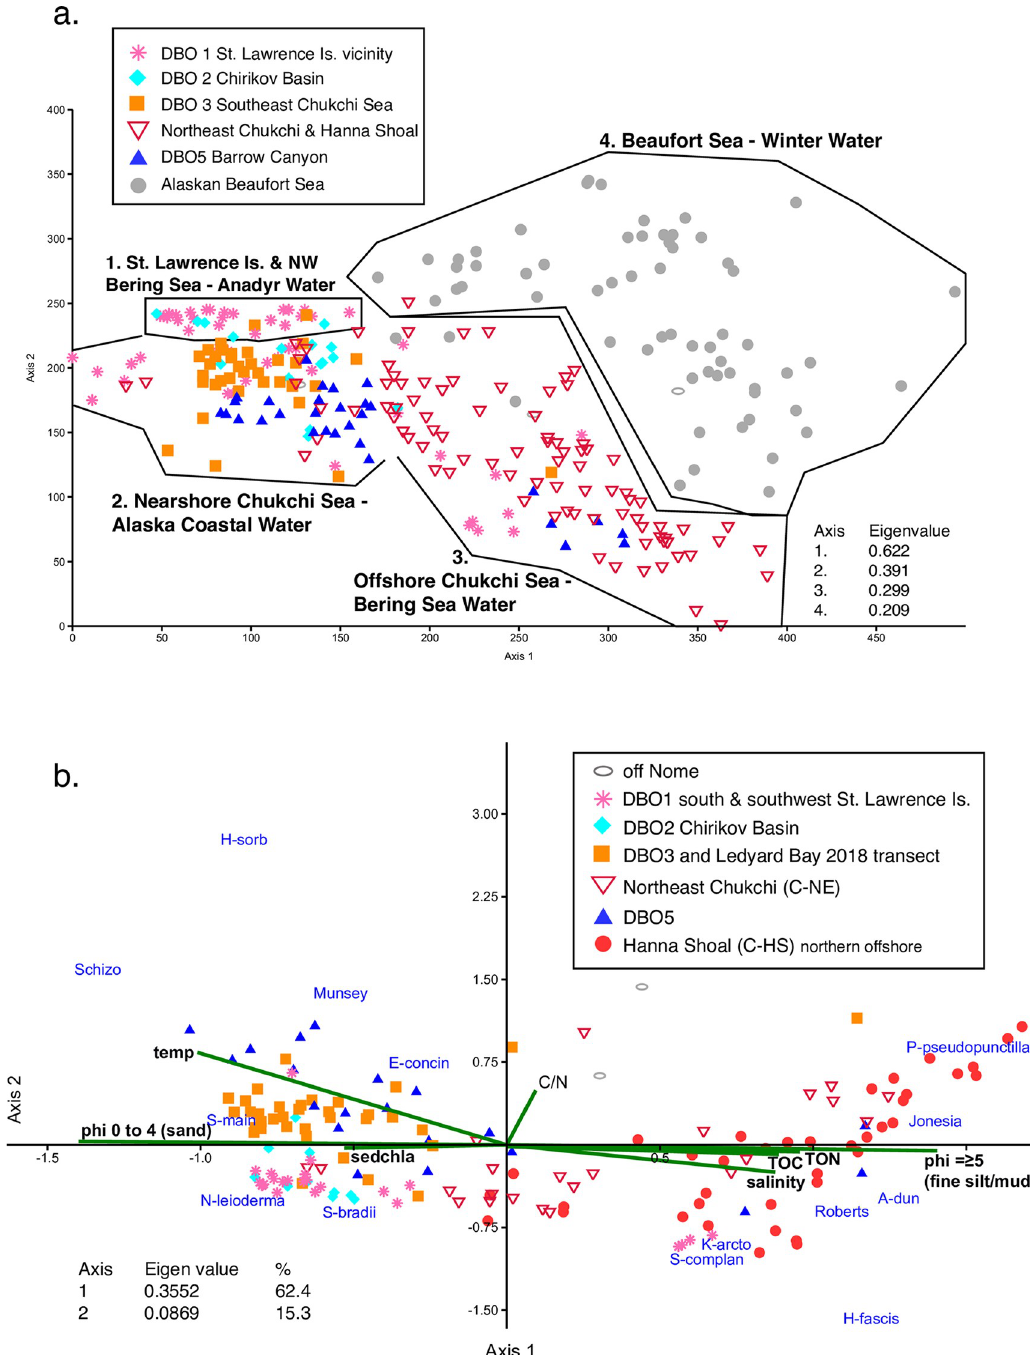
Fig 6. a . Detrended correspondence analysis (DCA). DCA using the northern Bering, Chukchi and Beaufort Seas biogeographic dataset (1970–2018), describes relationships between ostracode assemblage structure and geographic ecoregions in the region. Ostracode biofacies differed among ecoregions within the study area (described in Table 3) and grouped primarily on summer water mass characteristics (temperature and salinity). b . Canonical correspondence analysis (CCA). CCA of ostracode assemblages in the northern Bering-Chukchi Sea region, with sampling ecoregion sites (noted by symbol on legend), major taxa (names are labeled in blue), and eight environmental parameters (green lines and labels in black: temperature, salinity, sediment total organic carbon [TOC], sediment nitrogen [TON], sediment chlorophyll-a [sedchla], phi � 5 [fine silt], and phi 0–4 [gravel pebbles to sands]). Samples in the Hanna Shoal region (red dots) were separated from the larger northeastern Chukchi Sea sample set (inverted red triangle). Dataset includes the 14 most abundant species in 153 surface sediment aliquots (23,939 total specimens) from the northern Bering and Chukchi Seas during summers 1990–2018 for which sediment data was available. https://doi.org/10.1371/journal.pone.0251164.g006 PLOS ONE | https://doi.org/10.1371/journal.pone.0251164 May 13,